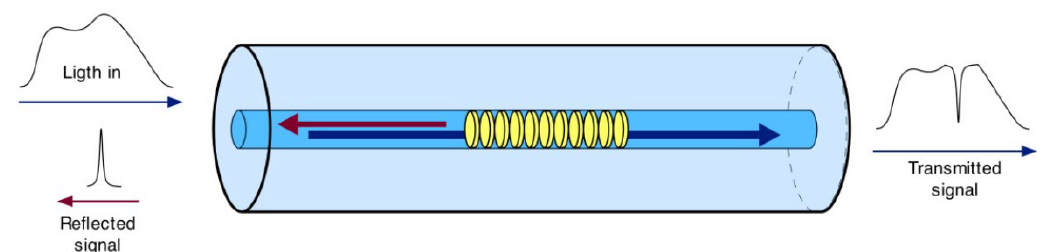
Figure 1. Transmitted and reflected signals during the interrogation of an FBG sensor